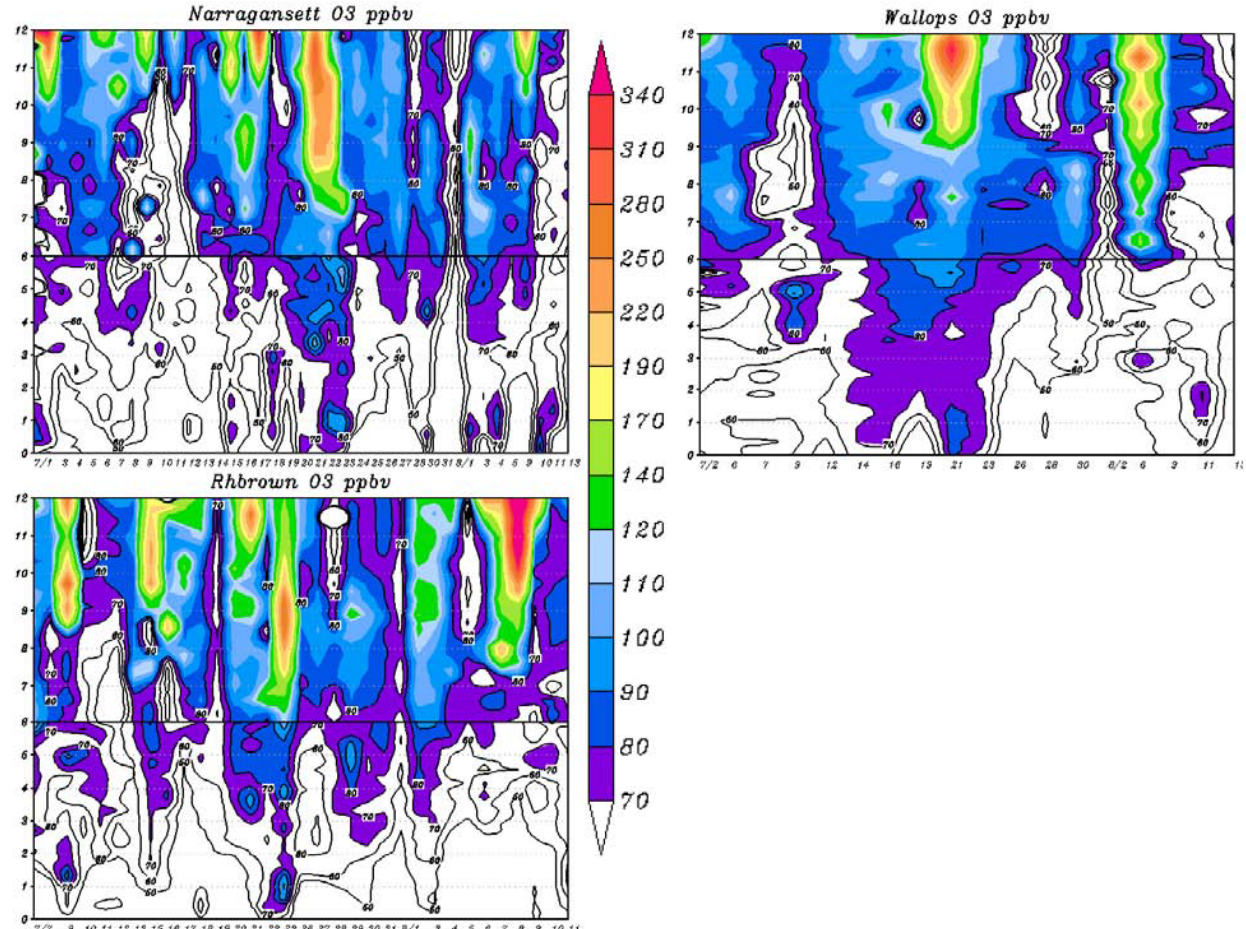
Figure 15. IONs-04 Ozone vertical profiles from surface to 12 km during their launching days (July-August) at Narragansett, Wallops, and RH Brown. Ozone values >70 ppbv are shaded. X-axis: launching dates. Y-axis: altitude in